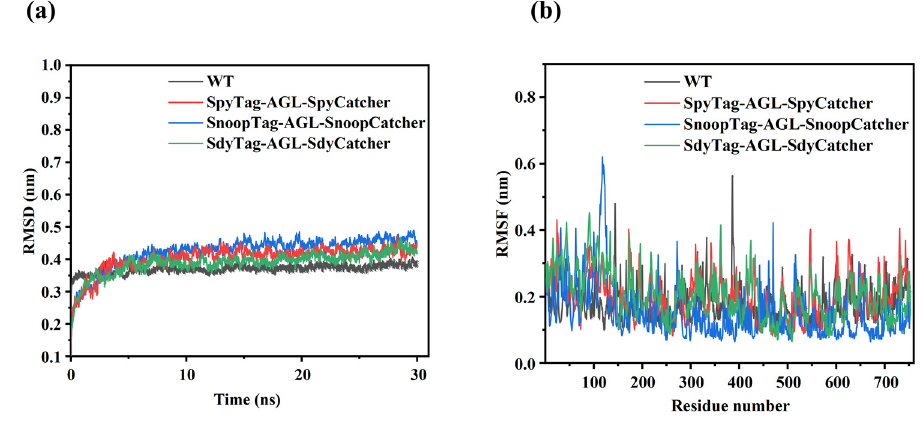
Figure 8. MD simulations of wild-type AGL and cyclized AGL. ( a ) RMSD values, ( b ) RMSF values.